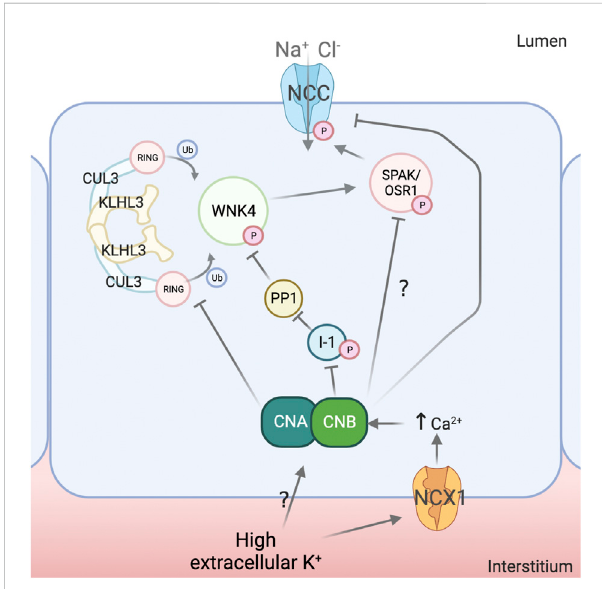
Mechanisms for NCC regulation by calcineurin. Calcineurin (CN) activity has been implicated in the dephosphorylation of the Na + -Cl - Cotransporter (NCC) in response to high extracellular K + . Modulation of the Na + -Ca 2+ exchanger (NCX1) activity by K + has been postulated as a mechanism to induce changes intracellular Ca 2+ concentration and thus promote CN activation, although this mechanism requires con fi rmation and additional mechanisms may also participate. Evidence suggests that CN can directly dephosphorylate NCC and also affect upstream elements of the signaling pathway. For instance, CN appears to dephosphorylate Kelch-Like 3 (KLHL3), which leads to increased ubiquitylation of With- No-Lysine (K) kinase 4 (WNK4) and Kidney-Speci fi c With-No-Lysine (K) kinase 1 (KS-WNK1) and, thus, decreased activation of Ste20- related Proline/Alanine rich Kinase (SPAK) and Oxidative Stress Responsive kinase 1(OSR1). Inhibitor 1(I1)has alsobeen shown to bea substrate of CN and, consequently, this protein may function as a node linking CN activation to Protein phosphatase 1 (PP1) activation, with the implications that this may have in the DCT (see Figure 1). Created with